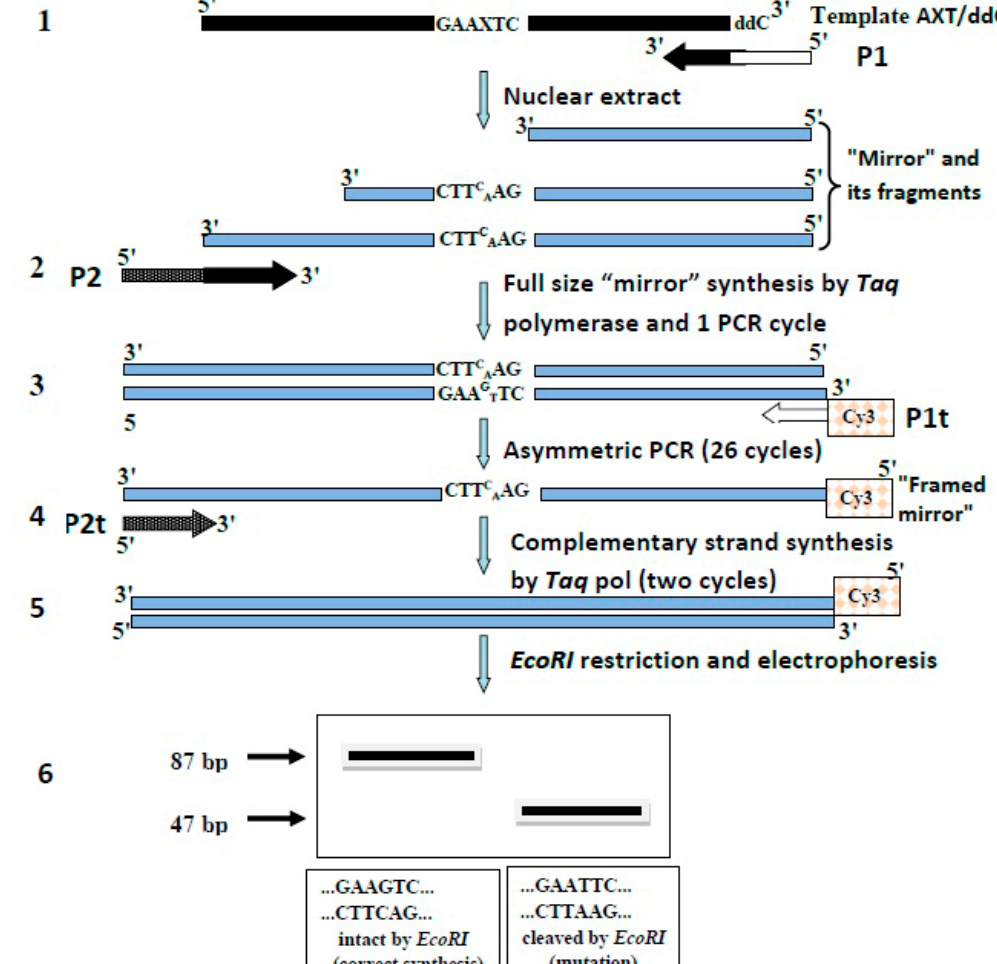
Figure 1. Scheme of the “framed mirror” method.